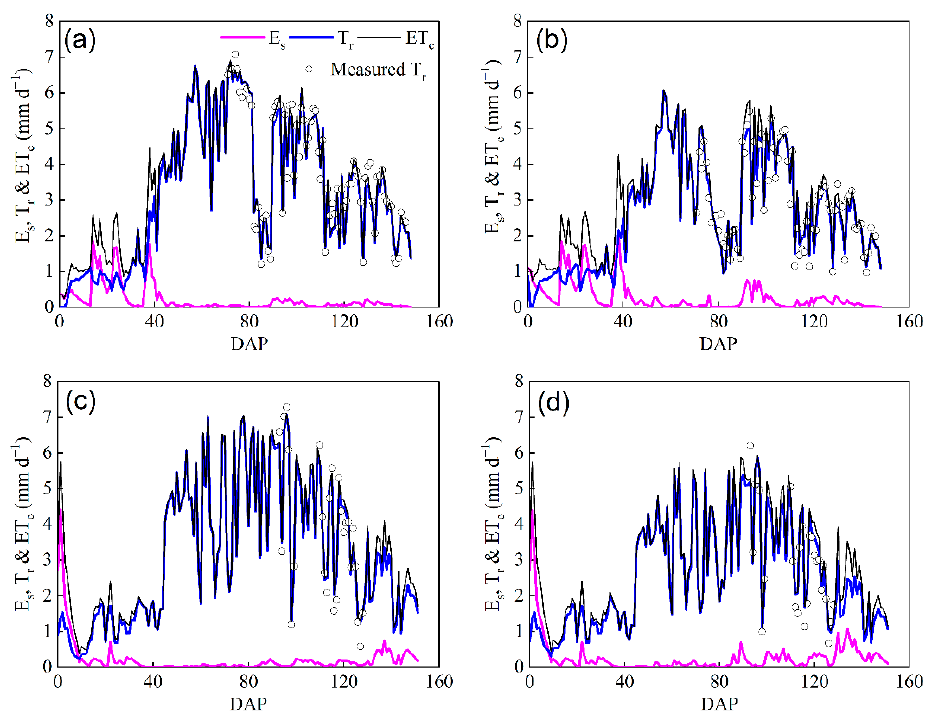
Figure 4. Dynamic variations of basic crop coefficient (K cb ), actual adjustment K cb (K cbadj ) and soil evaporation coefficient (K e ) for two water treatments (T1 and T2) with days after planting (DAP) during the whole growth period of maize in ( a , b ) and 2018 ( c , d ).